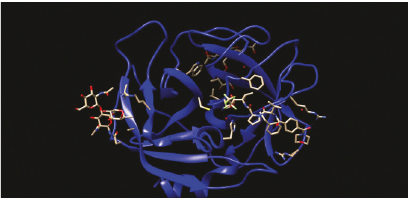
Figure 4: Identification of nsSNPs in the domains of ELANE gene